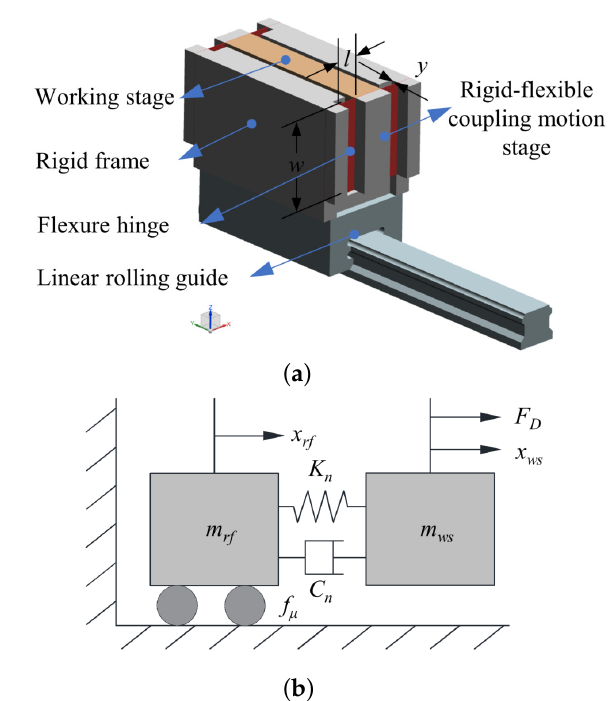
Figure 1. RFCMS: ( a ) Model diagram and ( b ) dynamic